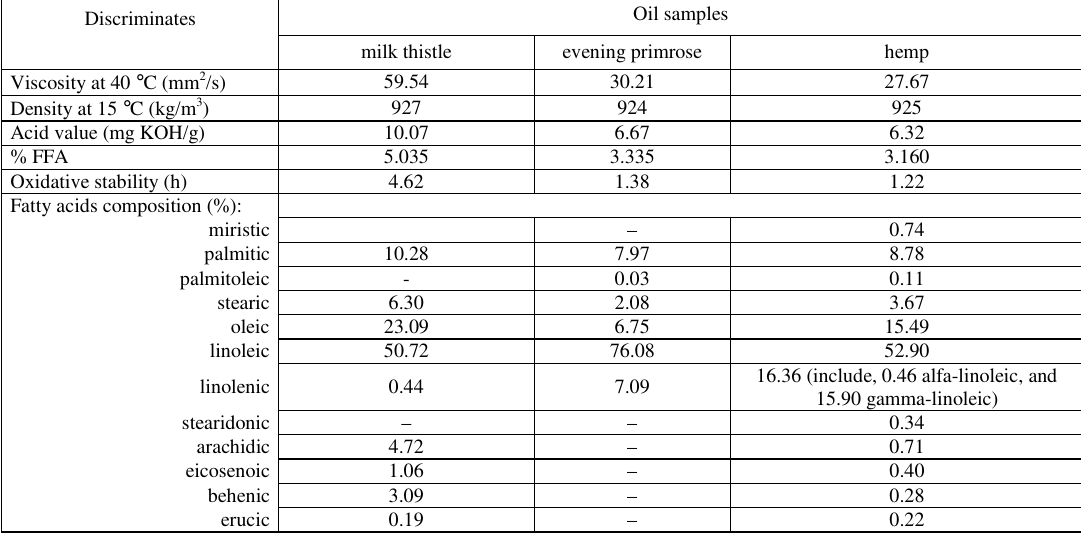
Table 1. Characterization of the analysed